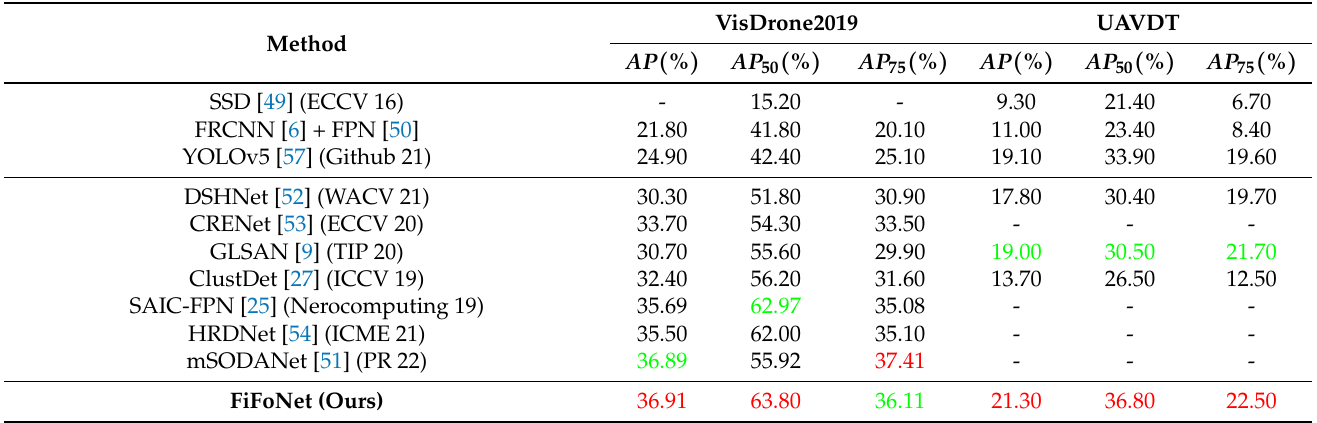
Table 7. Comparison of our method with the baseline and SOTAs on VisDrone2019-Val and UAVDT. ’-’ means that the statistics are not available. The top two results are highlighted in red and green fonts.